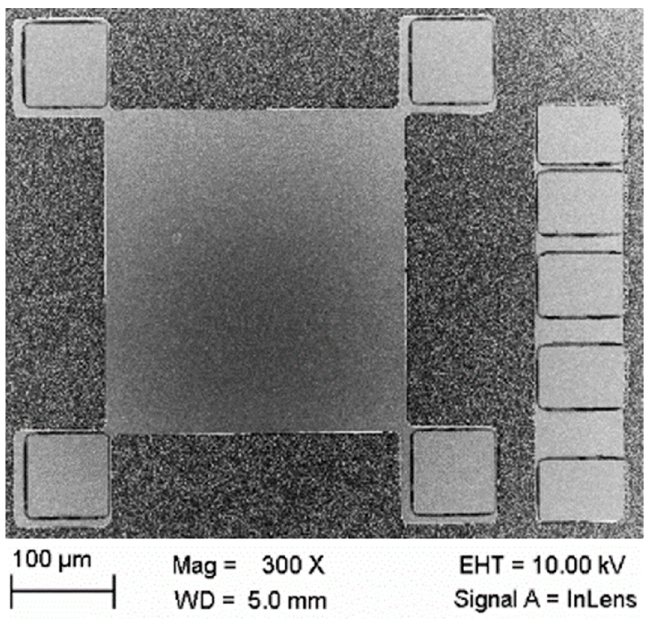
Figure 1. VDP (left) and LTLM (right) micro-structures prepared photolithographically.